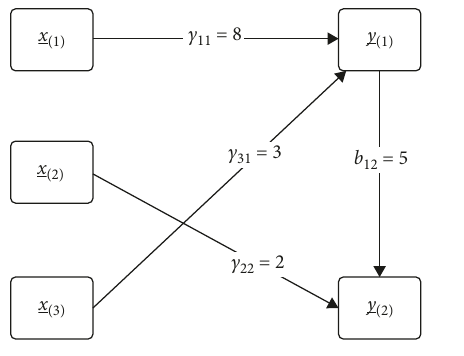
Figure 5: The identified path model for Example 2. Table 6: A 3SLS causal structure D -optimal design with three binary factors and random blocks where each block size is equal to four. Block 1 Block 2